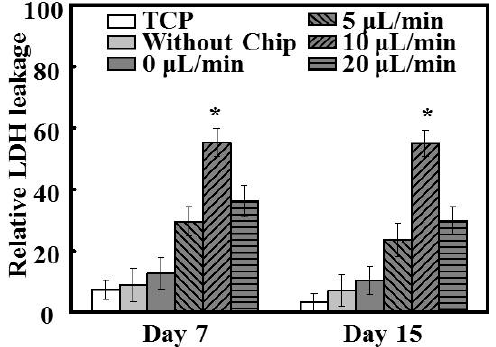
Figure 7. Relative lactate dehydrogenase (LDH) leakage from cells after 120 µ g/mL silver nanoparticles (Ag NPs) treatment for 24 h at days 7 and 15 of culture, compared with the values without Ag NPs treatment ( n = 5); * p < 0.05.